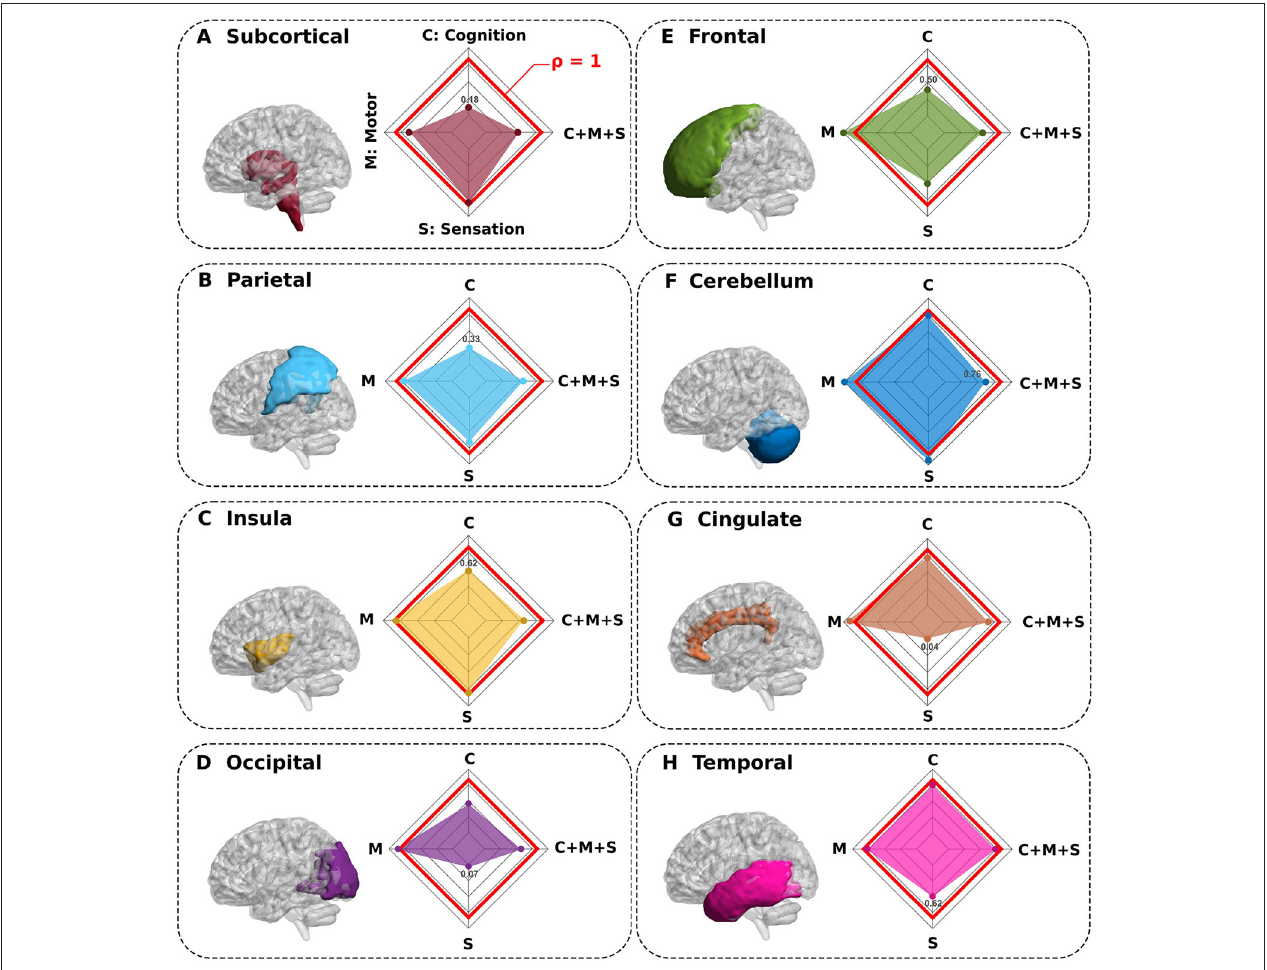
FIGURE 3 | Synthetic complete deletions of brain macroregions and their impact in predicting neuro-behavioral scores. (A–H) Eight different macroregions were completely deleted (separately one by one) to quantify the impact that each macroregion connectivity has in predicting behavior. In particular, after a macroregion deletion, we recalculated new connectivity matrices in its absence and re-calculated the association with behavior for this novel situation. All panels show the macroregion deleted and the performance ratio ρ between the synthetic deletion as compared to the situation where all regions were present (spider plot). While values of ρ close to 1 (red line in the spider plot) show regions such that their deletions do not greatly impact the behavior prediction, values smaller than 1 show the regions with highest contribution in predicting behavior (for each spider plot, the minimum value is